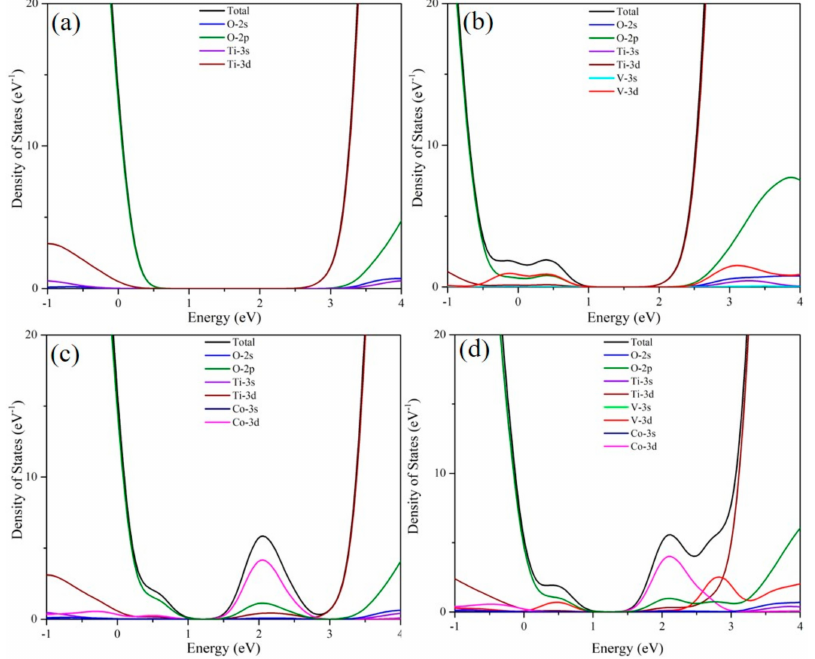
Figure 7. The DOS of ( a ) TiO 2 , ( b ) V–TiO 2 , ( c ) Co–TiO 2 , and ( d ) (V,Co)–TiO 2 .